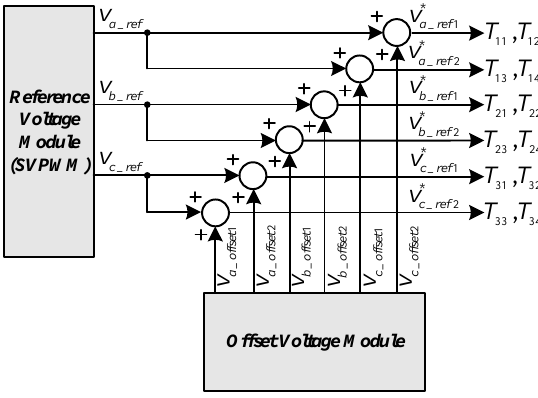
Figure 11. Control block diagram of proposed ZDPWM method.